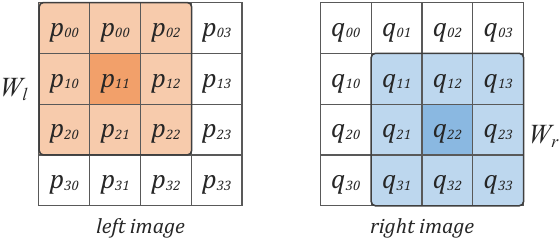
Figure 2. Feature match is diffused to its neighborhood pixels. For feature correspondence ( p 11 , q 22 ), build multi-to-multi matchings within the local windows W l and W r in its host images, then employ disparity gradient constraint and confidence measure to prune false